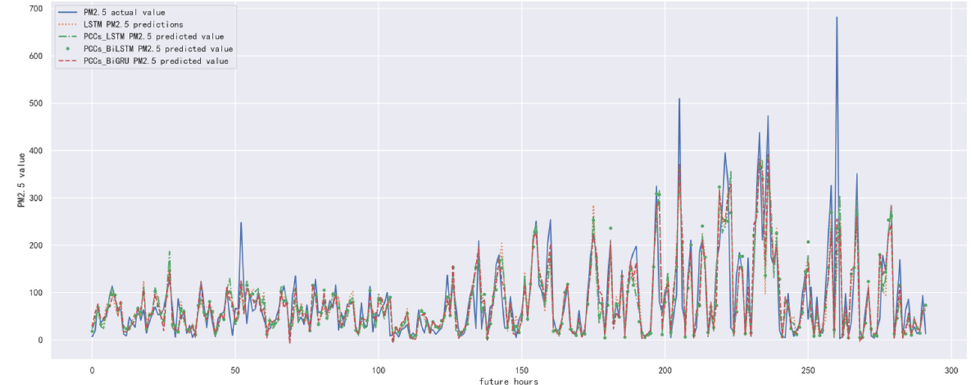
Figure 14. The schematic diagram of prediction results of PM 2.5 concentration in the next five hours.